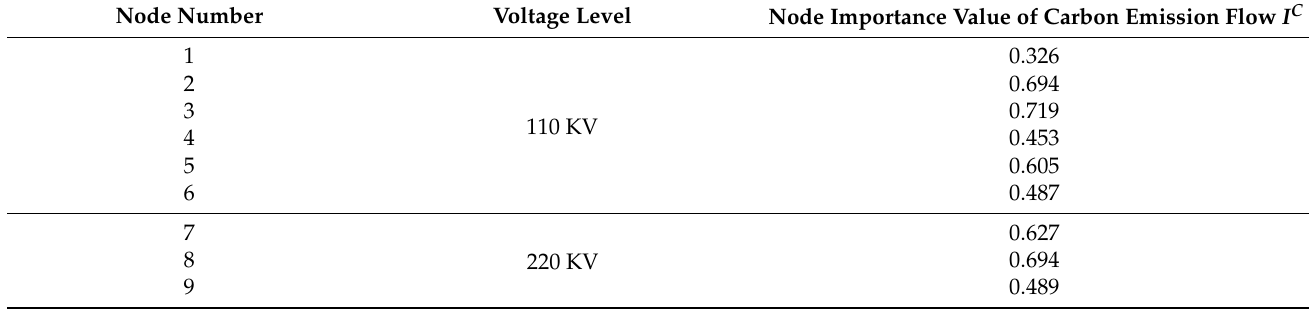
Table 7. Node importance value of carbon emission